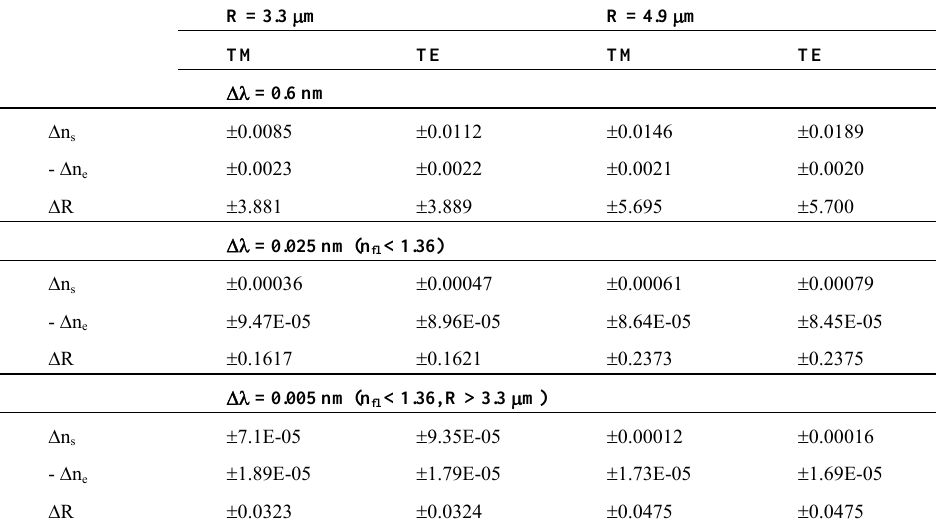
Table 2. Experimental errors for bead index, n R, in dependence of the uncertainty in determining the mode positions,  , for the smallest and largest bead